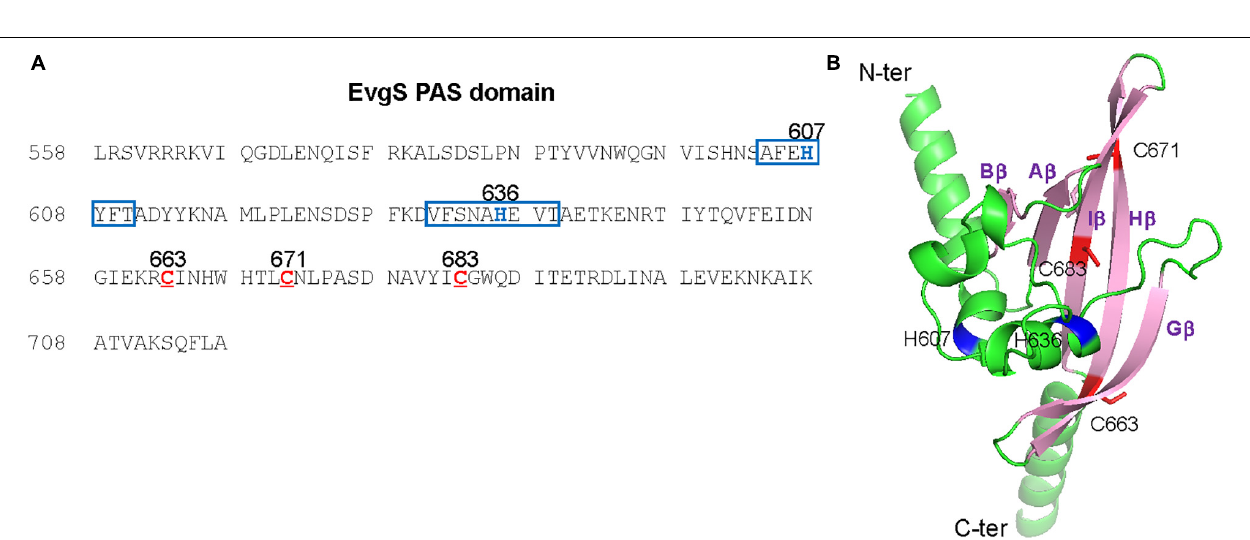
Frontiers in Microbiology |